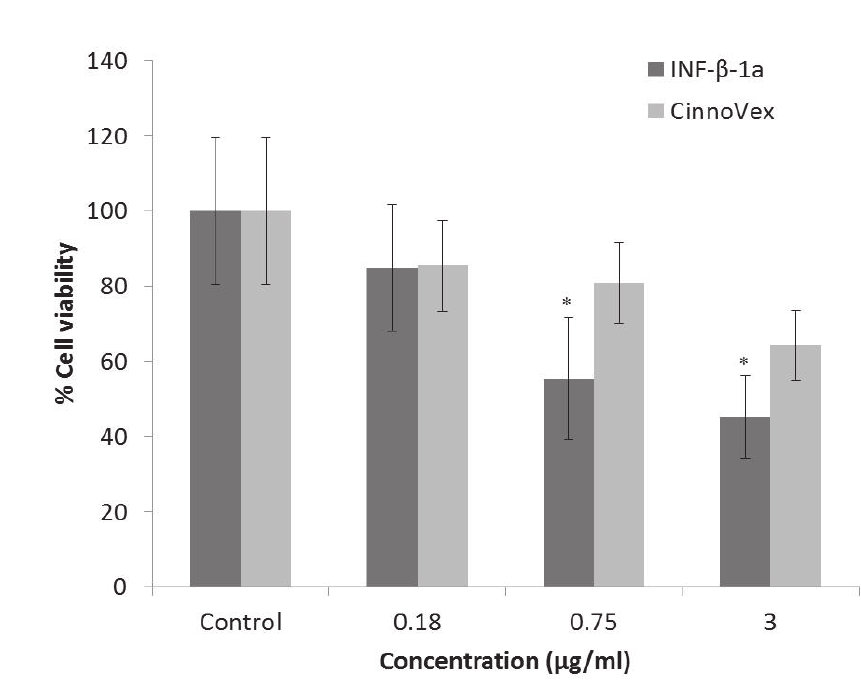
FIGURE 6 - The effect of INF-β-1a on viability of HepG2 cells as determined by MTT assay. Cells were incubated with various concentrations of INF-β-1a and CinnoVex, as a positive control, for 72 h (mean ± SD, n=8). Asterisk (*) indicates the means which were significantly different ( P <0.05) from the positive